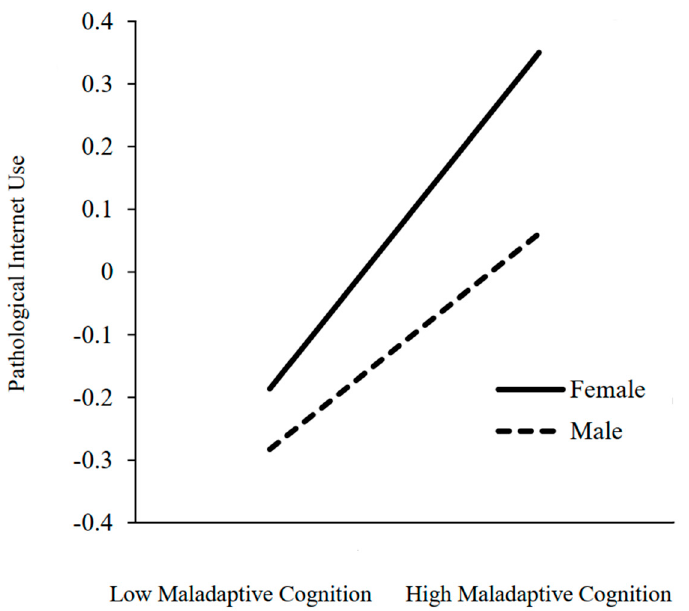
Figure 3. The interaction of maladaptive cognition and gender on PIU.